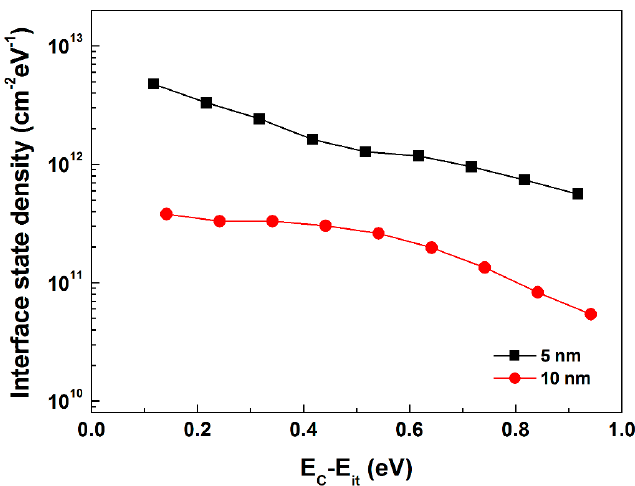
Figure 9. The energy distribution curves of the interface states obtained from the high- and low-frequency C – V characteristics.